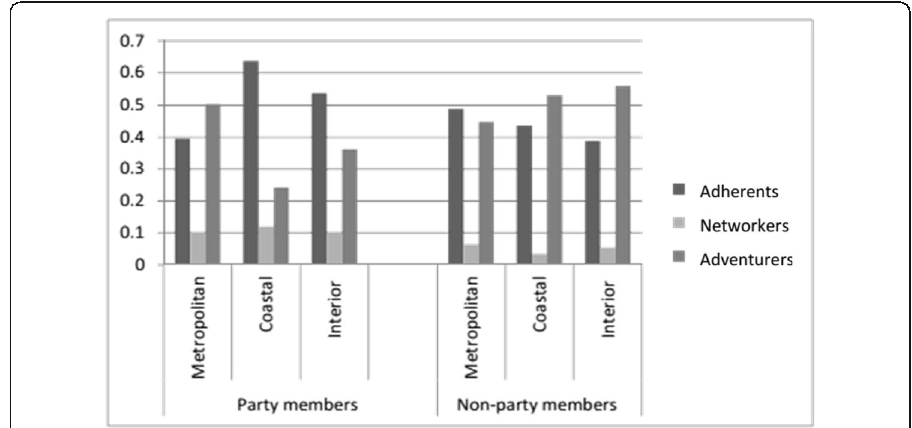
Fig. 6 Predicted probabilities of three types of successful job seekers by party membership and region — the left section shows compositions for party members and the right section shows compositions for non-party members; three regions are marked along the X-axis , while probabilities (between 0 and 1) are marked along the Y-axis ; the darkest grey colour indicates adherents, the lightest grey colour indicates networkers, and the last one indicates